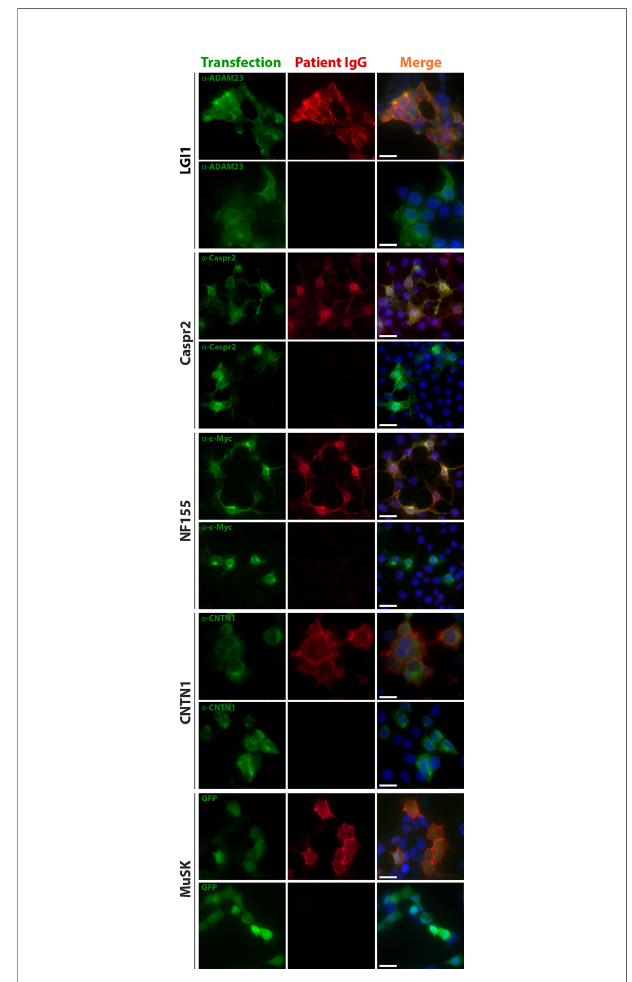
FIGURE 1 | Anti-neuronal/neuromuscular autoantibodies were detected using cell-based assays. Example images of sera positive and negative for LGI1, Caspr2, NF155, CNTN1 and MuSK autoantibodies are shown. Green fl uorescence indicates antigen expression by either counterstaining with commercial antibodies and secondary antibodies conjugated to AF488 or GFP co-expressed after an IRES site on the plasmid coding for MuSK. Red fl uorescence indicates patient autoantibodies detected by anti-human IgG conjugated to AF594. Blue fl uorescence corresponds to nuclear staining with DAPI. Scale bar , 20 µm. ADAM23 , disintegrin and metalloproteinase domain-containing protein 23; Caspr2 , contactin-associated protein-like 2; CNTN1 , contactin 1; GFP , green fl uorescent protein; IgG , immunoglobulin type G; LGI1 , leucine-rich glioma inactivated protein- 1; MuSK , muscle- speci fi c kinase; NF155 , neurofascin